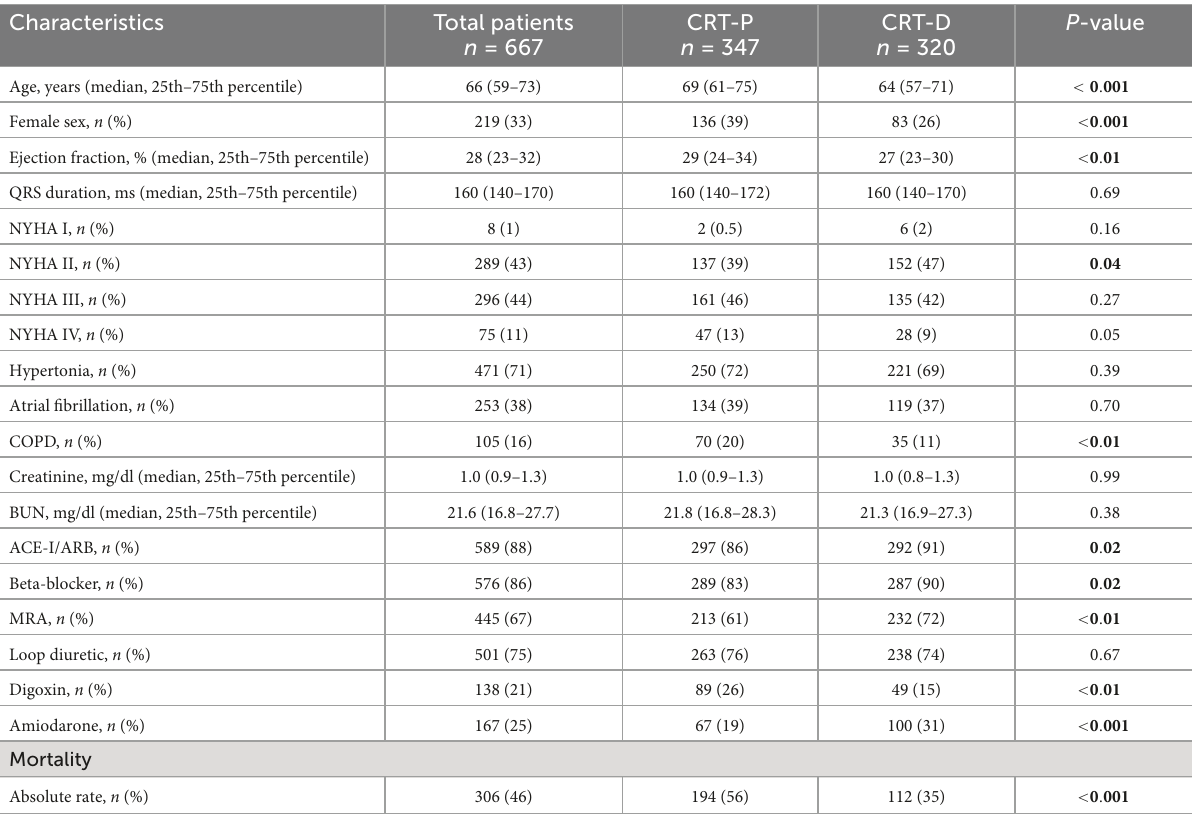
TABLE 1 Baseline clinical characteristics of the total patient cohort without very-high-risk (VHR) patients by device type.